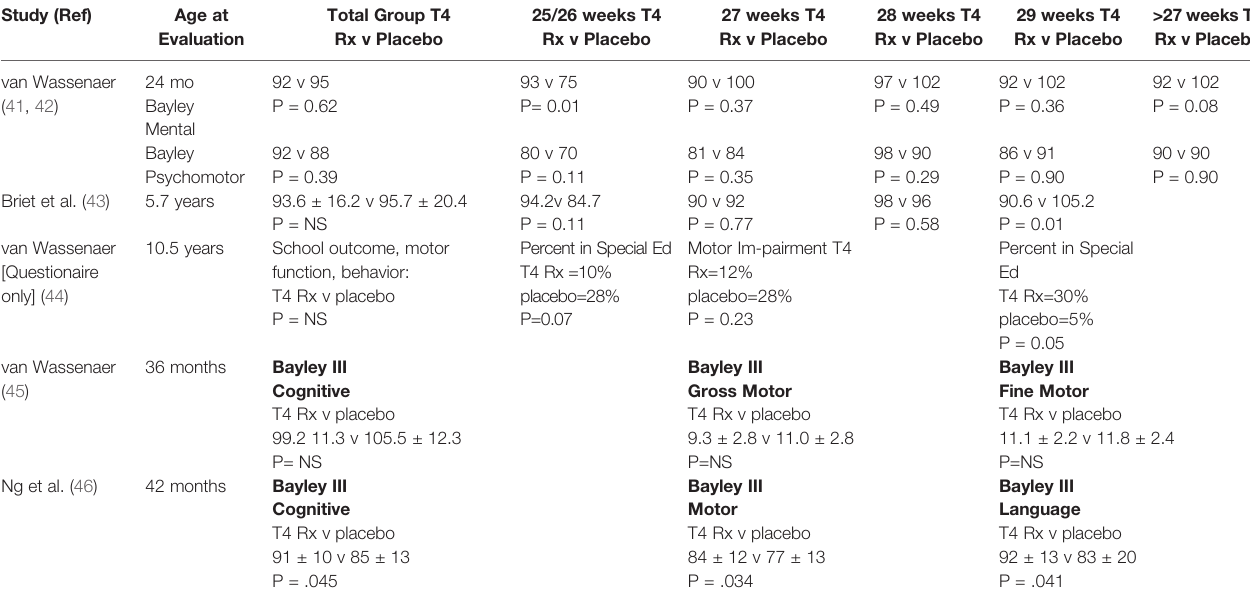
TABLE 2 | Summary of studies investigating l-T4 treatment v placebo on neurocognitive outcome in preterm infants. Study